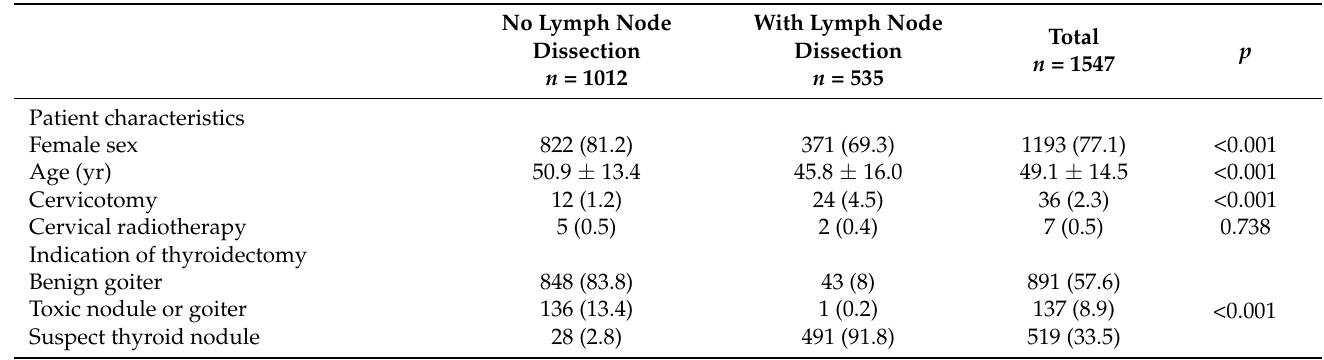
Table 1. Clinical, surgical and histological characteristics in patients who underwent total thyroidec- tomy with or without lymph node dissection for thyroid